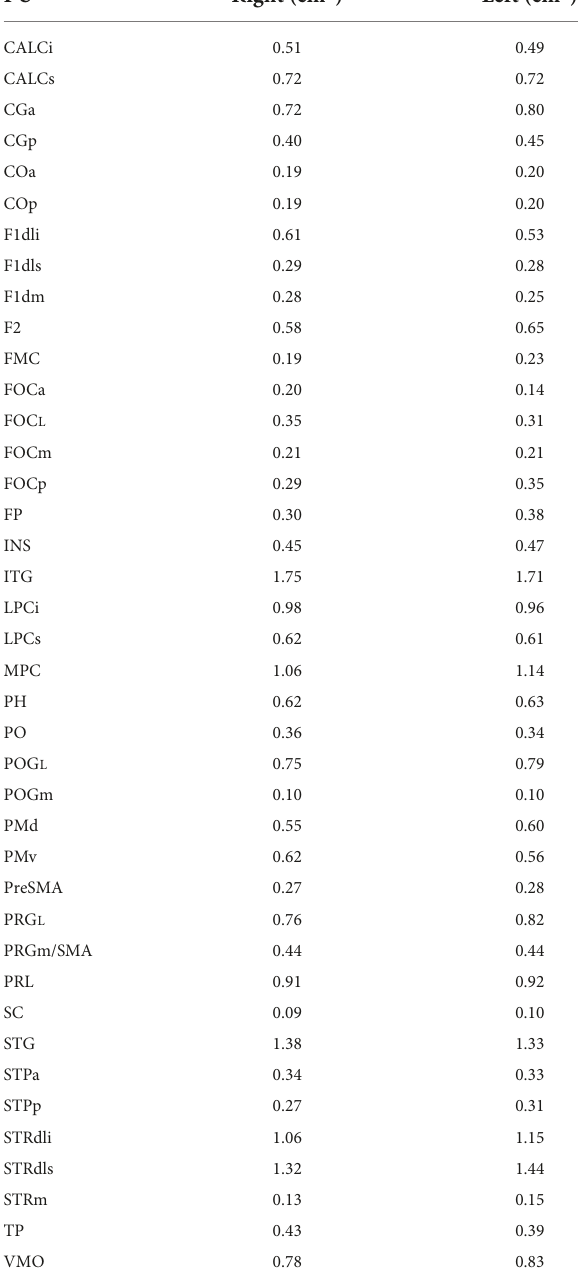
TABLE 10 Macaque Harvard-Oxford Atlas (mHOA) parcellation unit volumes from single subject. PU Right (cm 3 ) Left (cm 3